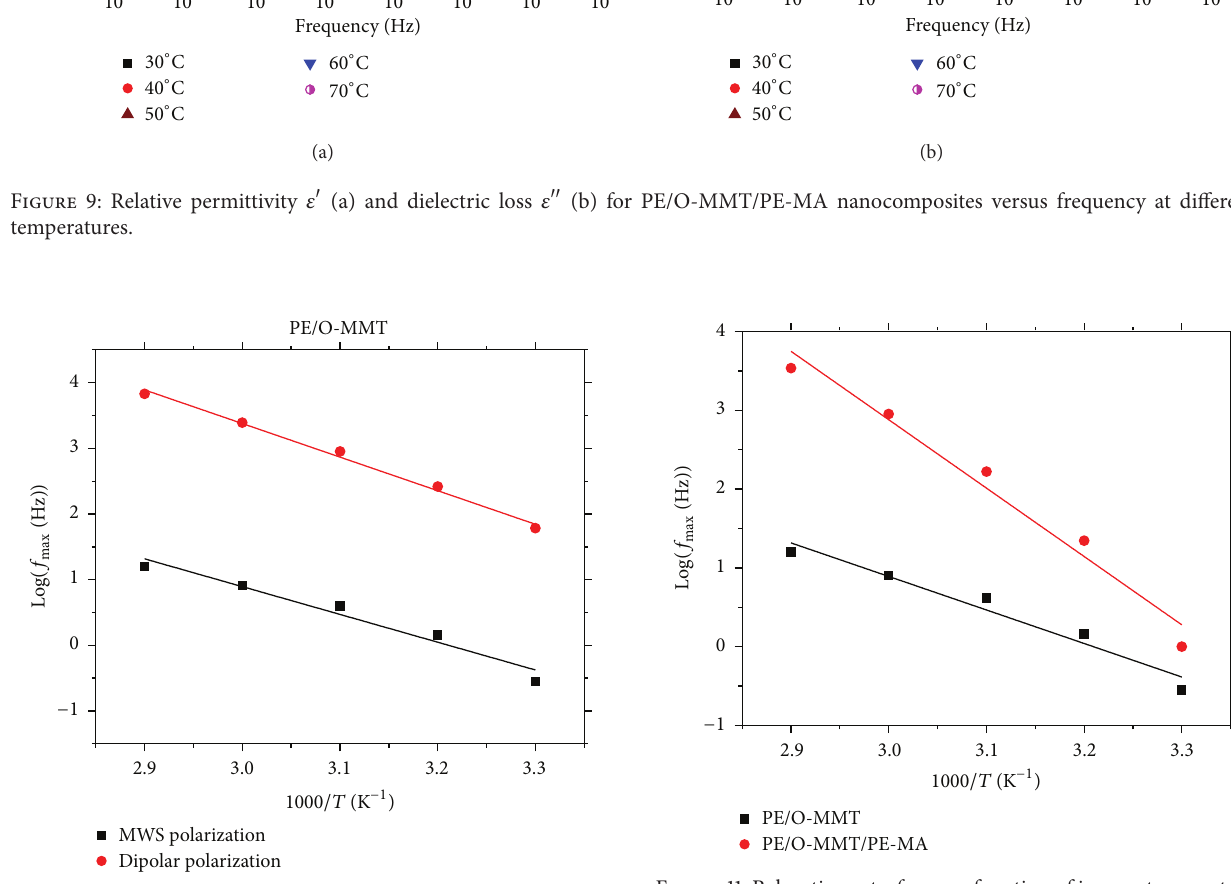
Figure 10: Relaxation rate 𝑓 max as a function of inverse temperature forthetworelaxationmodesobservedinPE/O-MMTnanocompos- ites. The solid lines represent best fits for the Arrhenius function.